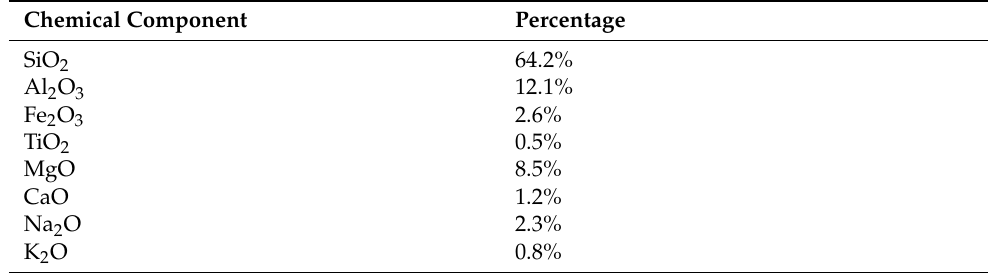
Table 2. Chemical components of the sodic